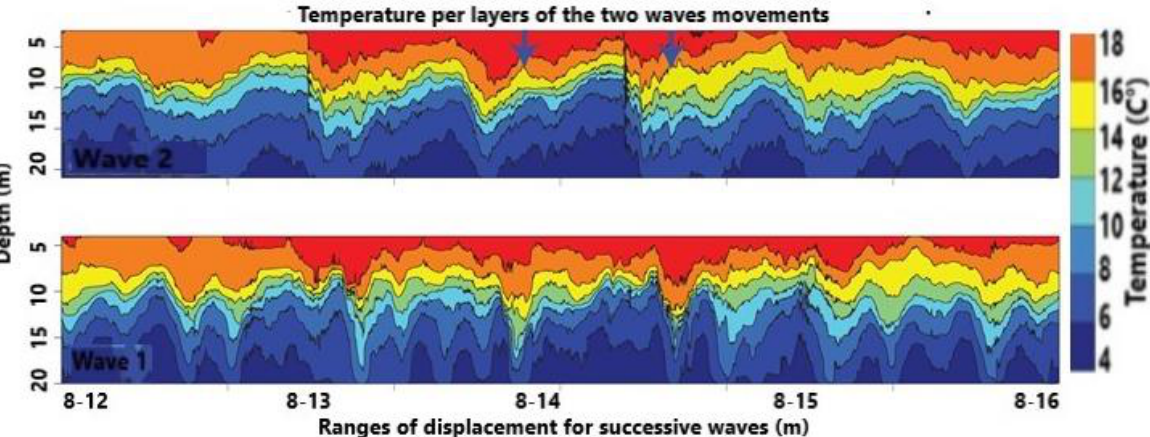
Figure 8. Temperature distribution during wave propagation and displacement steps.